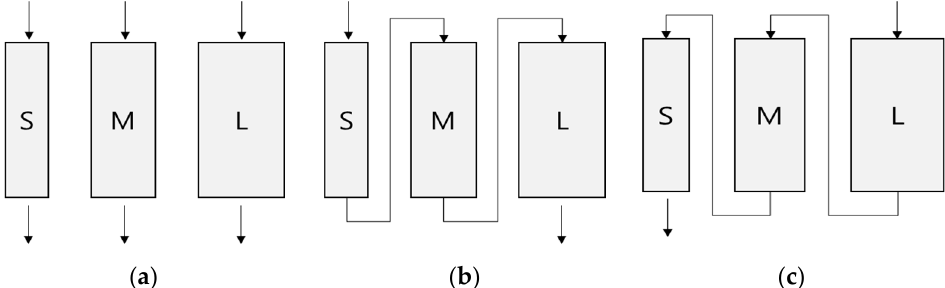
Figure 2. Diagram of a stacked microbial fuel cell (MFC) system operation according to the hydraulic flow connection mode: ( a ) Individual MFC operation (phase I), ( b ) a stacked MFC system operating in a forward hydraulic flow series connection mode (phase II), and ( c ) stacked MFC system operating in a reverse hydraulic flow series connection mode (phase III); the arrow means the direction of hydraulic flow.